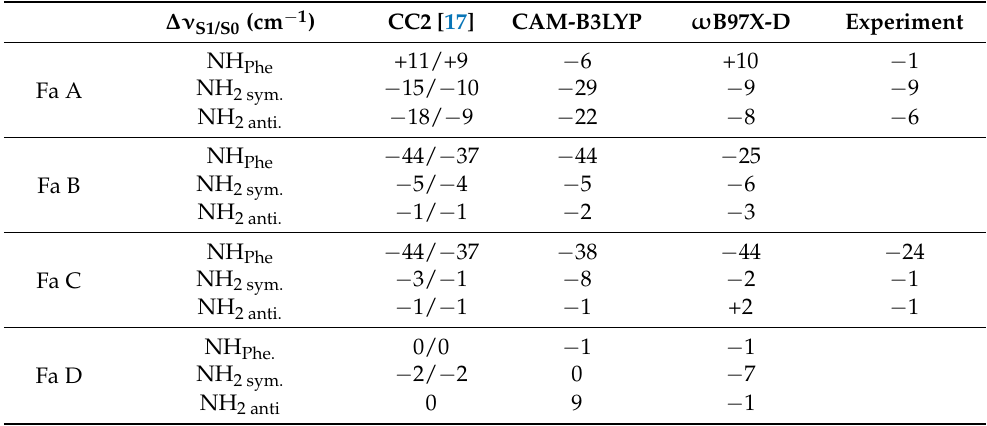
Table 2. Theoretical shifts (harmonic x and mode-dependent corrected y, i.e., x or x/y) of the amide A region frequencies of the lowest ππ * excited state optimized geometry (S 1 ) relative to the ground state optimized geometry (S 0 ) for the Fa A–D conformers obtained at the CC2/, CAM-B3LYP and ω B97X-D/ /cc-pVDZ levels, together with the corresponding available experimental data (cm − 1 ). ∆ ν − 1 ) CC2 [17] CAM-B3LYP ω B97X-D Experiment S1/S0 (cm NH Phe Fa A